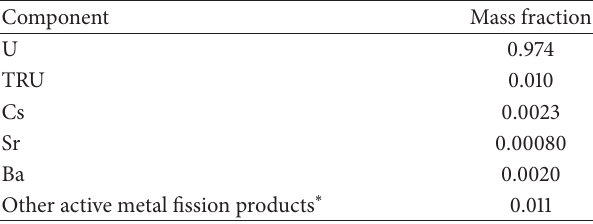
Table 4: Nominal composition of oxide used fuel. Mass fraction calculatedonmetalbasis(oxygenneglected).Compositionbasedon ORIGIN calculation of 33 MWd/kg burn-up, 10-year decayed